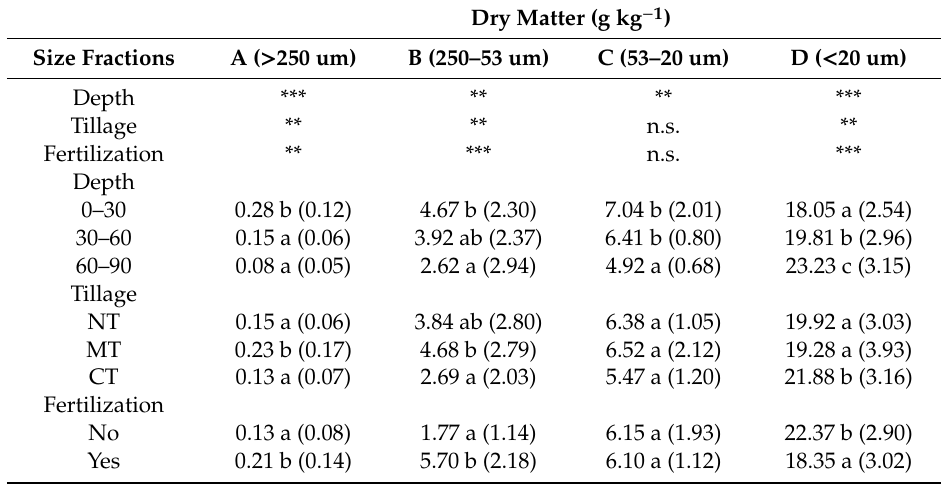
Table 2. Analysis of variance and mean values of the amount of each soil fraction subdivided by soil depth, tillage, and fertilization treatment. The standard deviation is in